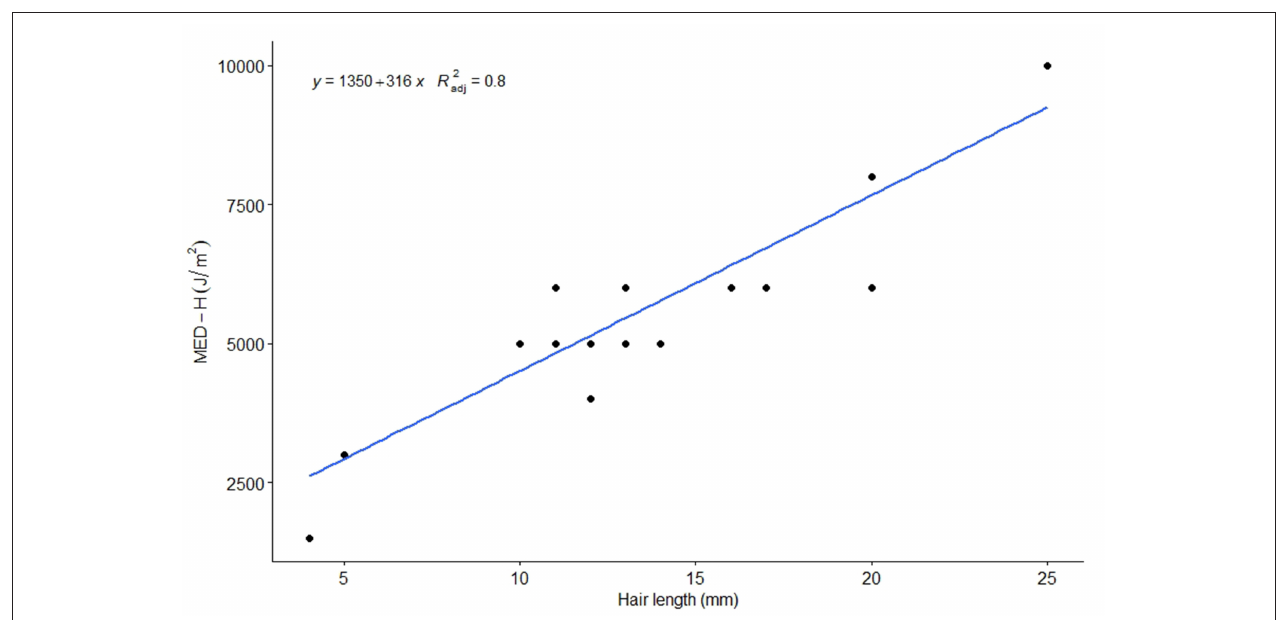
FIGURE 5 | Linear regression model presenting the association between hair length and minimal erythema dose on intact-hair-covered skin (MED-H).